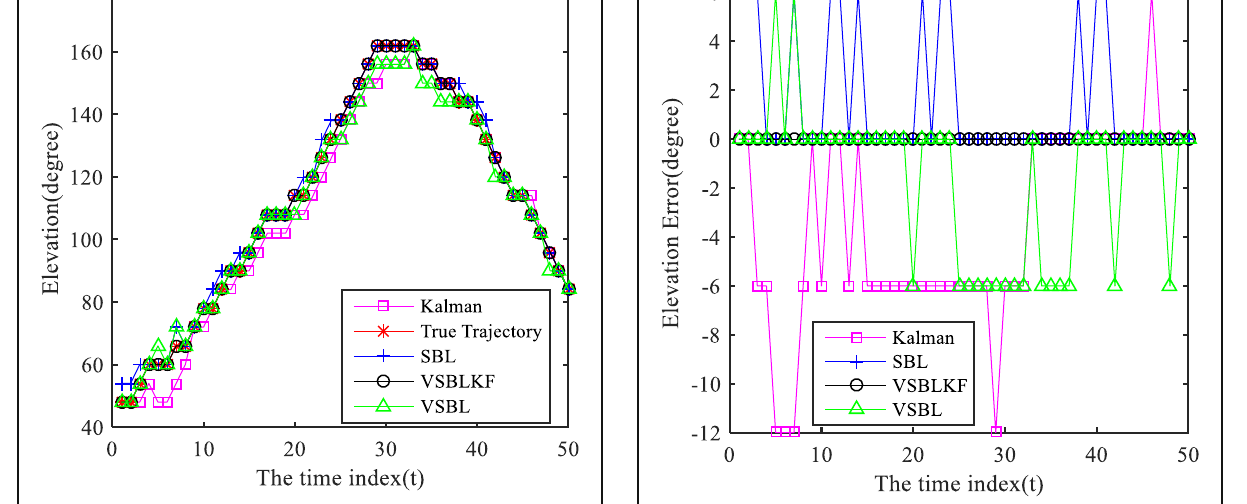
Fig. 6 Estimated elevation as a function of time